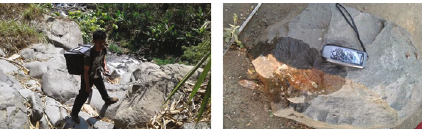
Figure 13: Massive rock outcrop at the gravity measurement